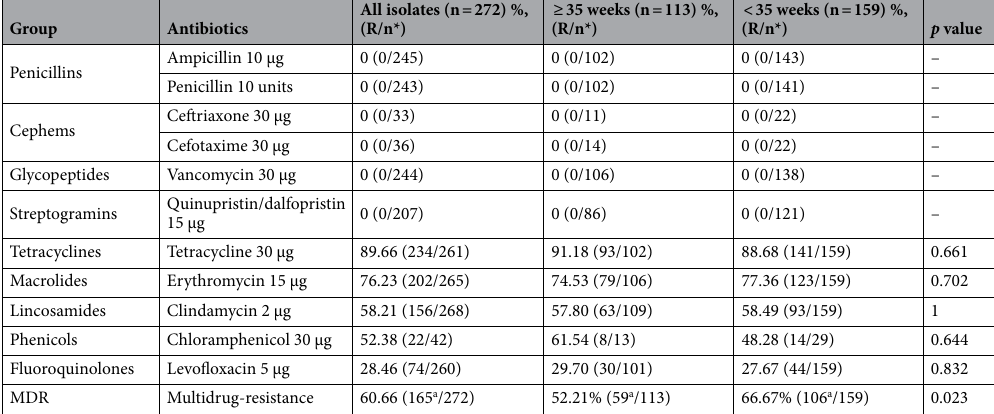
Table 2. Antibiotic-resistant rate of maternal GBS colonization. (–) Not examined, MDR multidrug resistance (resistant to at least one antibiotic in ≥ 3 drug classes), R Number of resistant isolates. *The number of isolates tested (not all isolates tested are equivalent as some data were missing). a Number of multidrug resistance isolates.